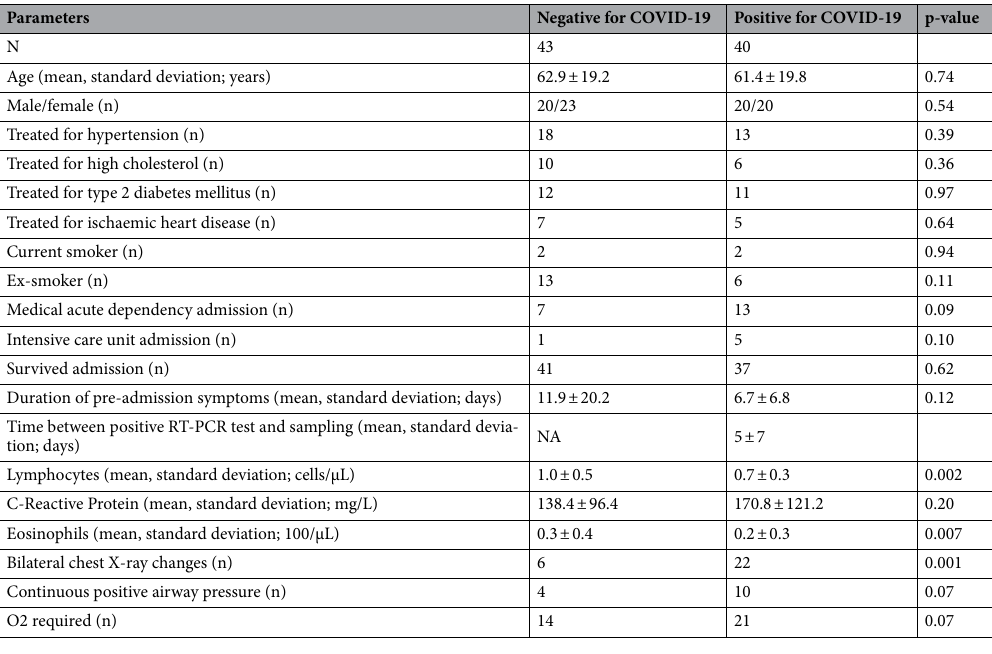
Table 1. Characteristics of study